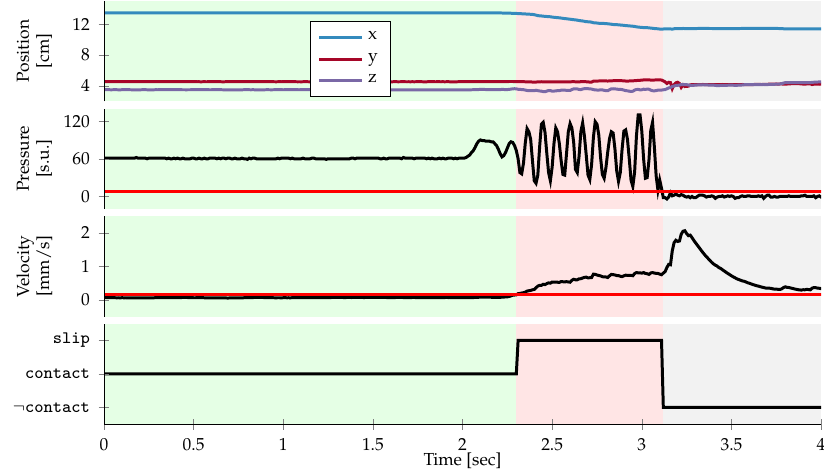
Figure 3. Data from the index finger during a single, representative training trial. The Cartesian instantaneous velocity was calculated from differences in finger end-effector position between two consecutive time steps. A pressure threshold, T Contact , and a movement threshold, T Movement , both indicated with red dashed lines, were used to generate the slip ground truth labels shown in the bottom